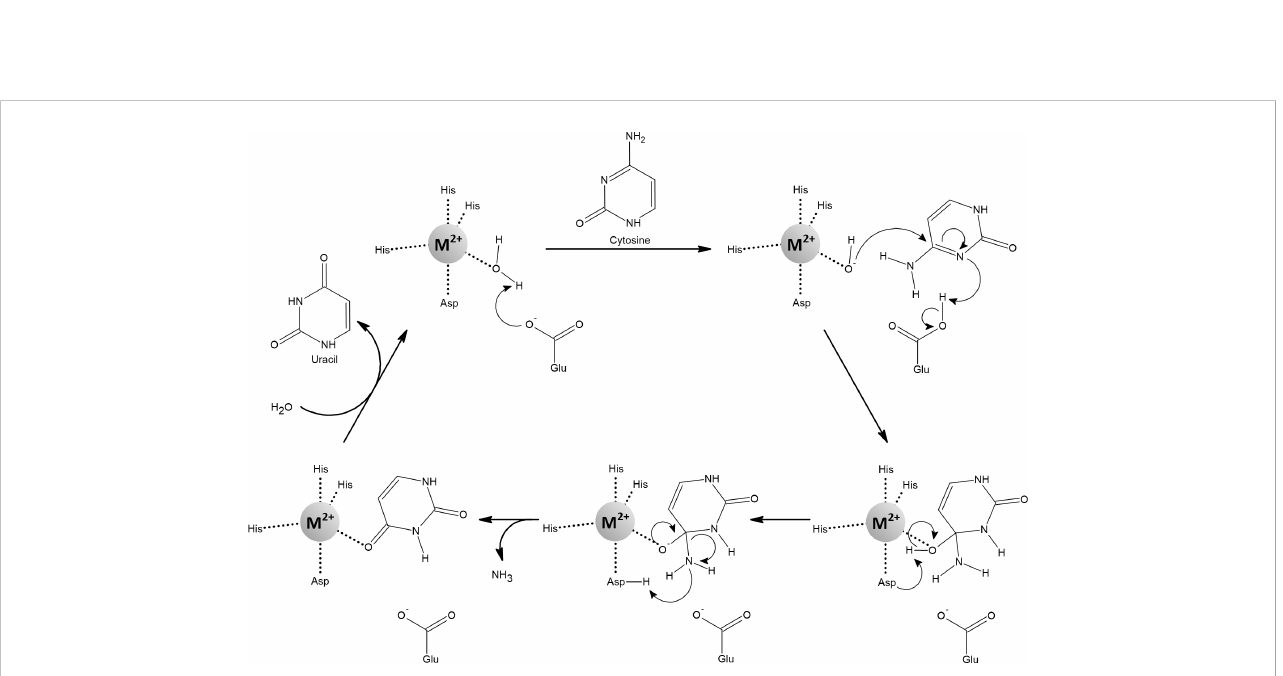
FIGURE 13 The conversion of cytosine to uracil catalyzed by bacterial cytosine deaminase. The metal ion accommodates a trigonal-bipyramidal geometry with an exchangeable ligand that is a water molecule. A proton is removed from this coordinated water molecule and in the next step the metal-coordinated hydroxide nucleophilically attacks the substrate, simultaneously transferring a proton to the substrate. In the next step, the second proton is transferred from the original water molecule (now hydroxyl group) to the amine group, producing ammonia that leaves the substrate. This step is probably facilitated by the metal-coordinating aspartate. The new water molecule displaces the uracil. Various metals can facilitate this reaction, but iron is most effective (Porter and Austin, 1993; Ireton et al., 2002b; Hall et al., 2011; Anjem and Imlay, 2012; Manta et al., 2014).